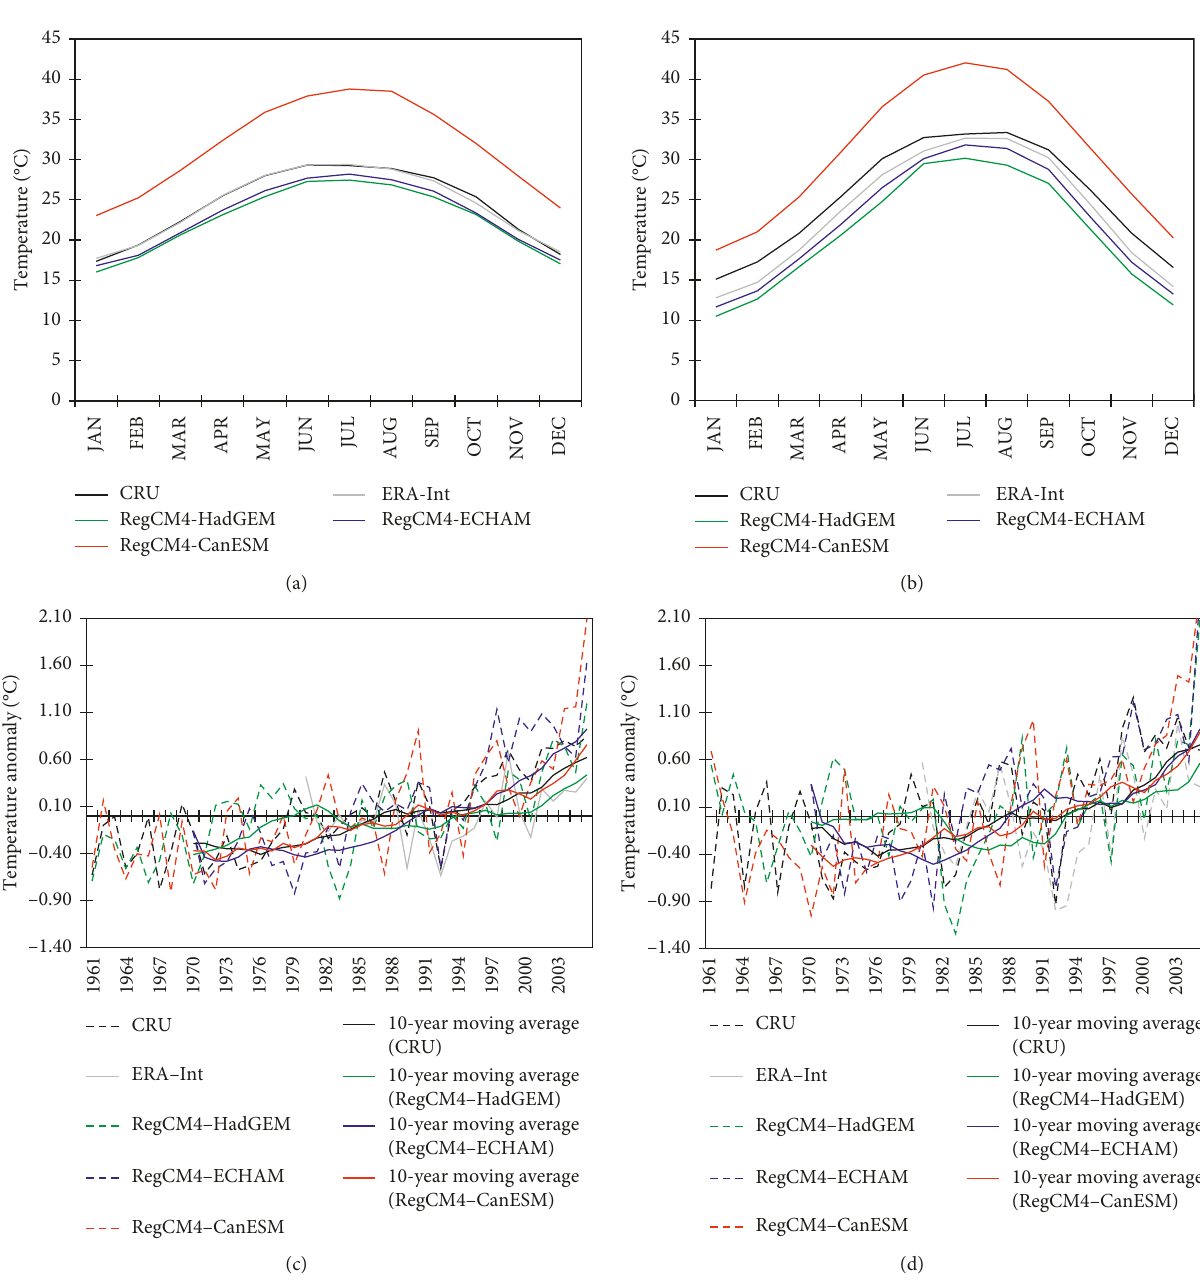
Figure 2: Annual cycle average temperature for (a) CORDEX-MENA/Arab domain and (b) Arabian Peninsula subdomain for the present climate 1971–2005. Temporal evolution for the relative temperature (each time series minus the 1971–2000 average of each source) for (c) CORDEX-MENA/Arab domain and (d) Arabian Peninsula